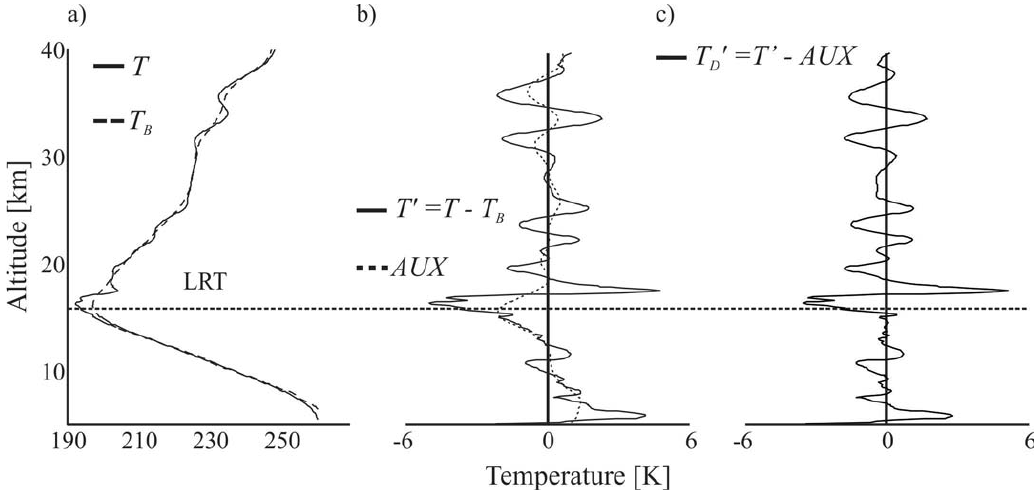
Fig. 4. Same as Fig. 3 for a second GPS RO event (Satellite COSMIC 1, lon=44.47 ◦ , lat=7.01 ◦ , 21 March 2010,